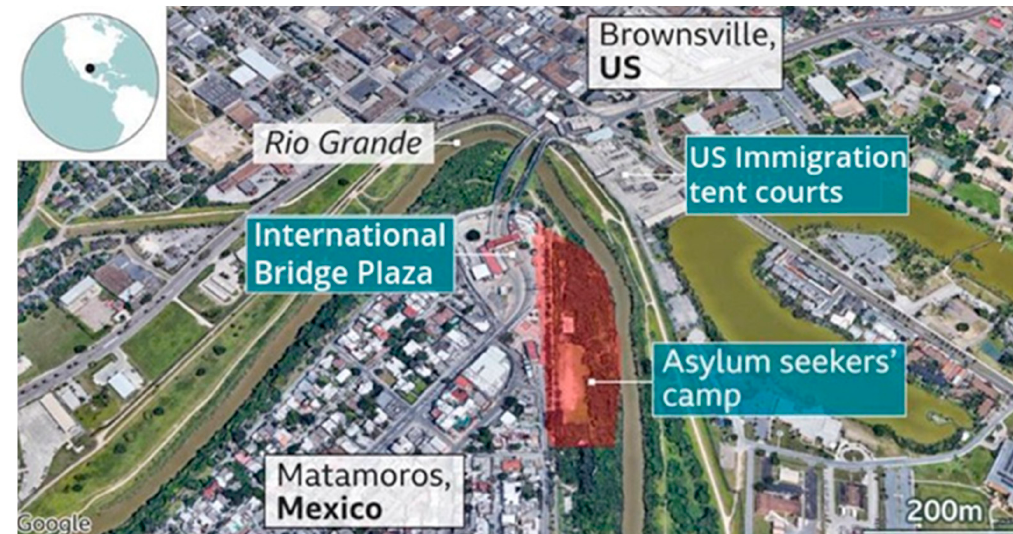
Figure 3. Location of the MPP camp and the international bridge connecting the US and Mexico. Image source: Google Earth, earth.google.com/web/. Text and shading modified from Rodgers and Bailey (2020). Reproduced with permission from BBC News; published by BBC,